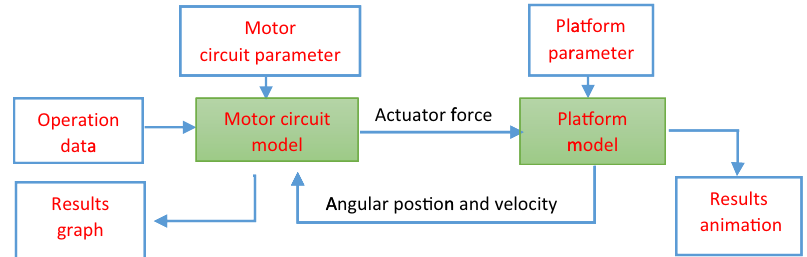
Figure 8: The schematic of the simulation process.